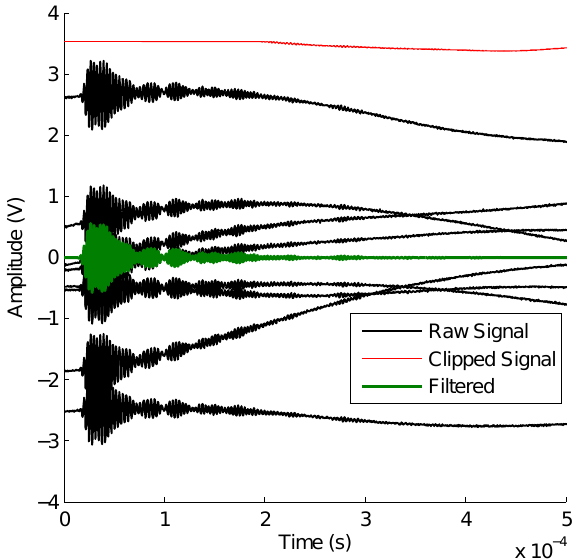
Figure 10. Signal recorded under random vibration highlighting signal clipping. Actuation at 300 kHz on a DuraAct CFRP plate with eight